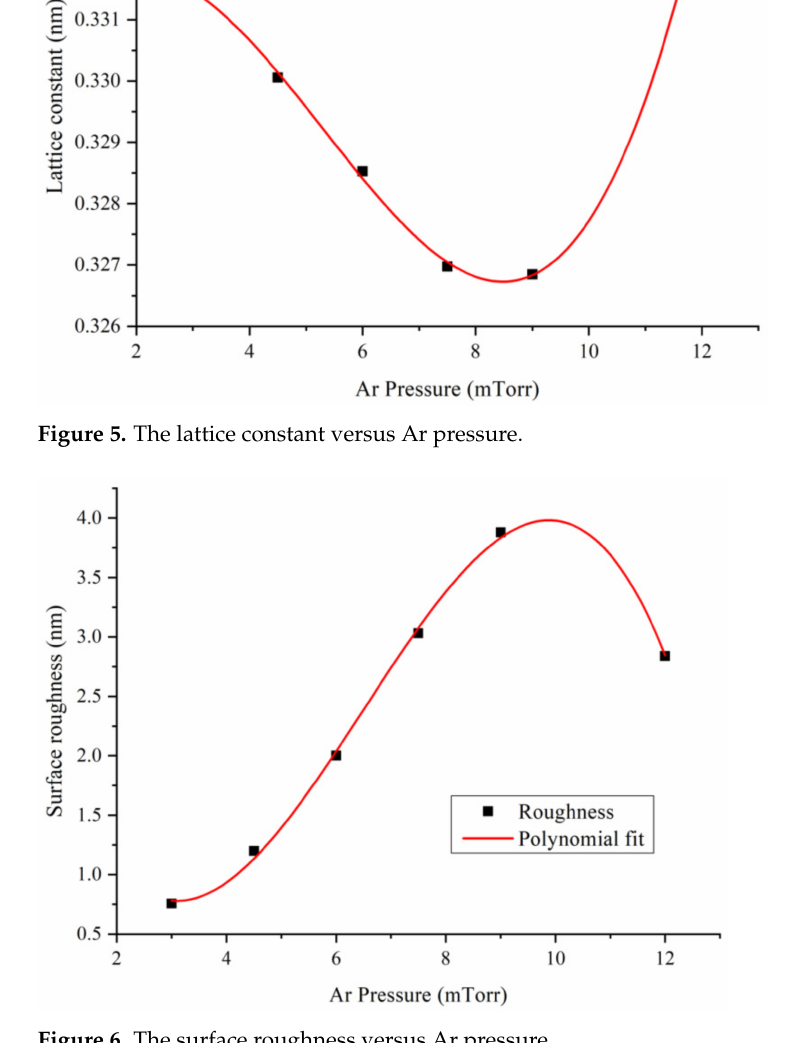
Figure 6. The surface roughness versus Ar